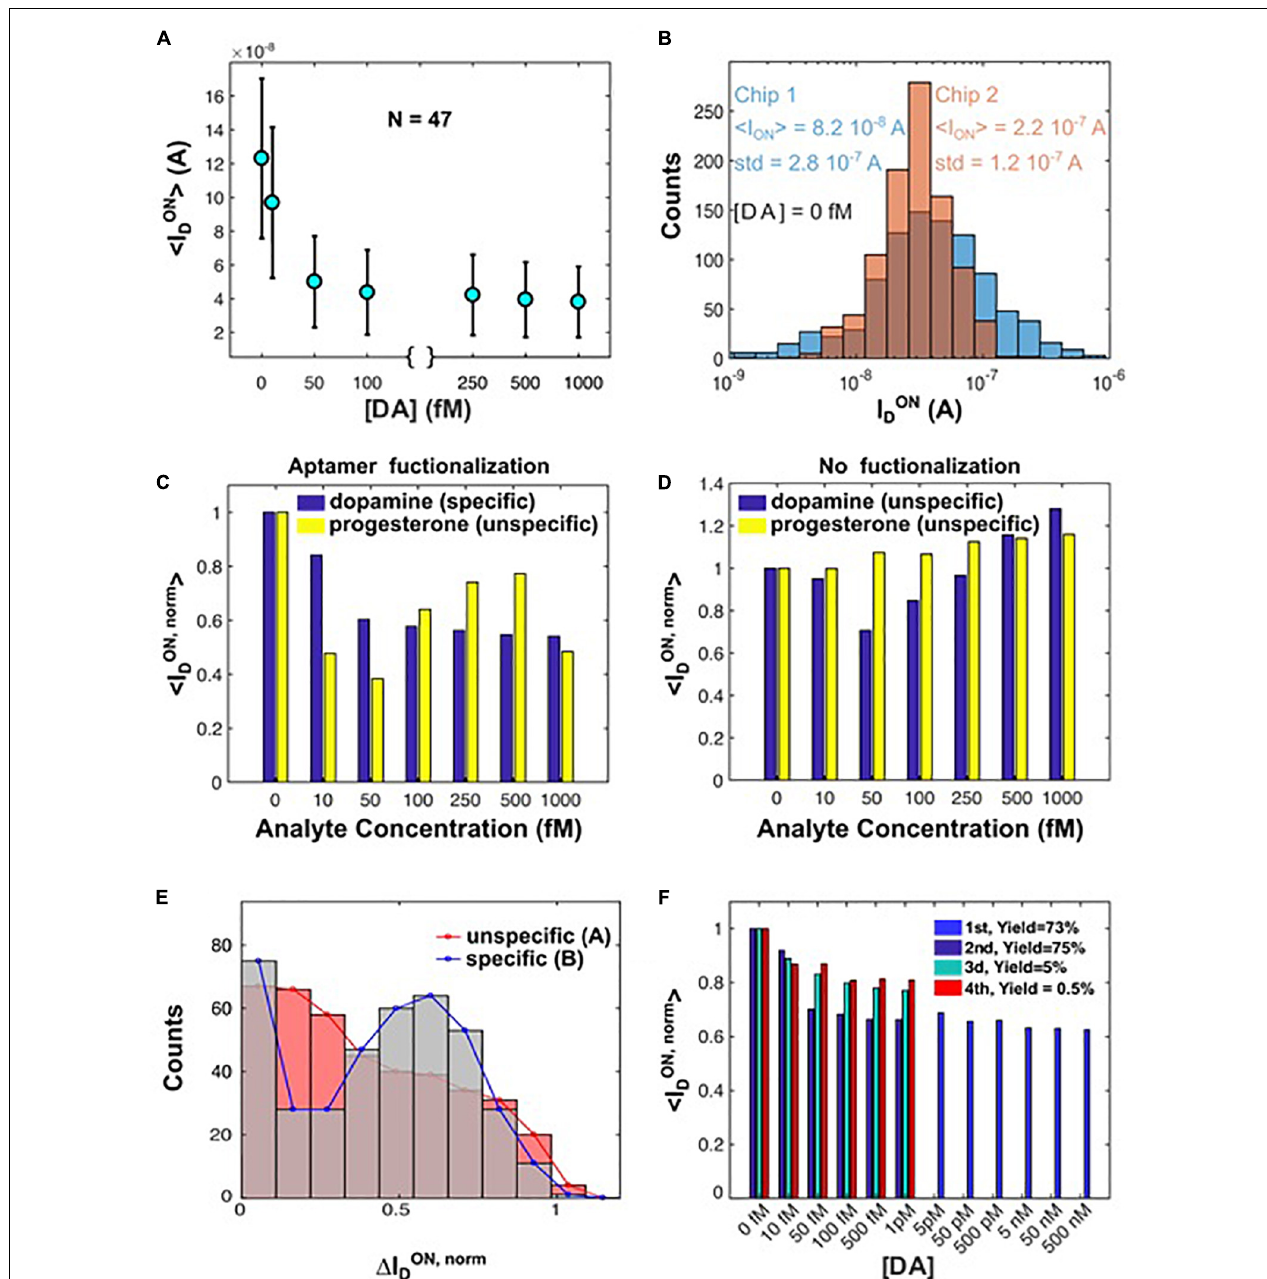
FIGURE 5 | (A) Average ON drain current versus [DA] for a small subset (N = 47) of SiNW sensors with similar ID ON in the initial state without DA. ID ON was extracted from the transfer characteristics at V LG = − 1 V. (B) Chip-to-chip variation of ID ON at [DA] = 0 fM. (C,D) Controls: for a selection of sensors, response to dopamine and progesterone extracted from transfer characteristics, with (C) and without (D) aptamer functionalization. (E) Sensor response to [DA] = 1 pM, for unspecific (sample area “A”) and specific (sample area “B”) functionalization. (F) Reusability: normalized ON drain current for each run of four consecutive dopamine sensing experiments, performed on the same chip. After each cycle the chip surface was cleaned and freshly functionalized with aptamer.